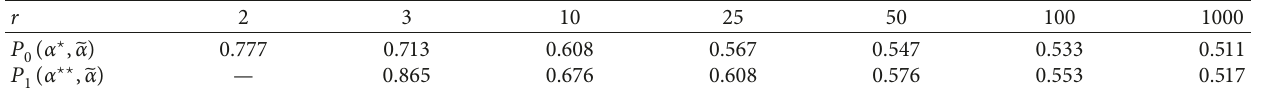
Table 3: Estimates of α attached with their MSEs when the left endpoint is known or unknown based on X of r and n , where X i , i � 1 , 2 , ... , r , follow the Weibull distribution F ( t ) � 1 − exp (− ( t − 5 ) /10 ) 2 , and t ≥ 5with t ≥ 5 t ≥ 10, i.e., F ∈ D ( W is assumed to be known The left endpoint x The left endpoint x 0 n r